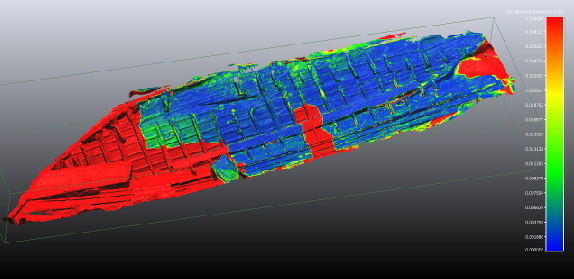
Figure 11. Comparison between point clouds 2014 and 2015 by photogrammetry.